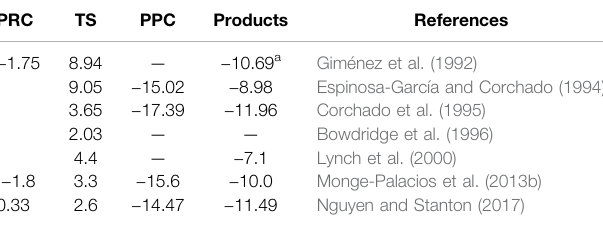
TABLE2| Summaryofthecalculatedenergies relativetoreactants(inkcal/mol)of the stationary points in the MEP for the OH + NH 3 reaction reported in the literature (see text for more details).